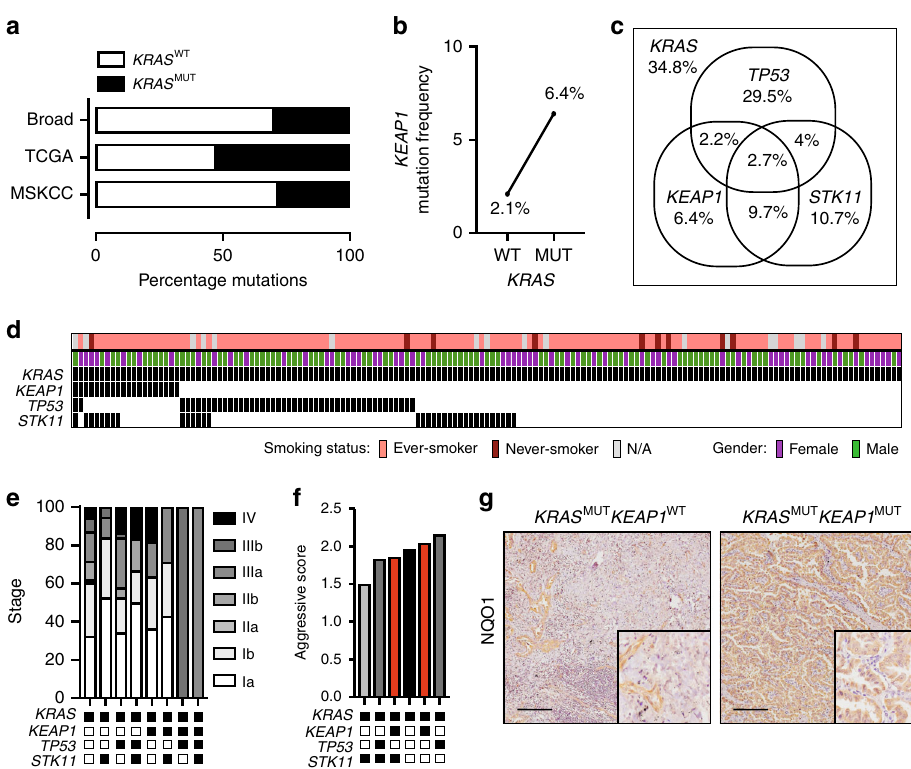
Fig. 1 KEAP1 mutation is enriched in KRAS -mutant lung adenocarcinoma. a Frequency of KRAS mutation in lung adenocarcinoma (LUAD) obtained from the Broad Institute ( n = 182), The Cancer Genome Atlas ( n = 313) and the Memorial Sloan Kettering Cancer Center (MSKCC) ( n = 864). b Frequency of KEAP1 mutation status in KRAS WT (wild type; n = 921) or MUT (mutant; n = 627) LUAD samples. c Venn Diagram of co-mutation/mutual exclusivity of KEAP1 , TP53, and STK11 mutations in the subset of KRAS -mutant LUAD ( n = 627). d KEAP1 , TP53, and STK11 mutation status in KRAS -mutant LUAD patient samples from the Clinical Lung Cancer Genome Project (CLCGP) cohort ( n = 155). e Frequency of clinical stage in subsets of KRAS -mutant LUAD from ( d ). f Aggressive score assessed by clinical stage in each KRAS -mutant subgroup. g NQO1 immunostaining on KRAS MUT KEAP1 WT TP53 MUT and KRAS MUT KEAP1 MUT TP53 WT patient samples. Scale, 200 μ